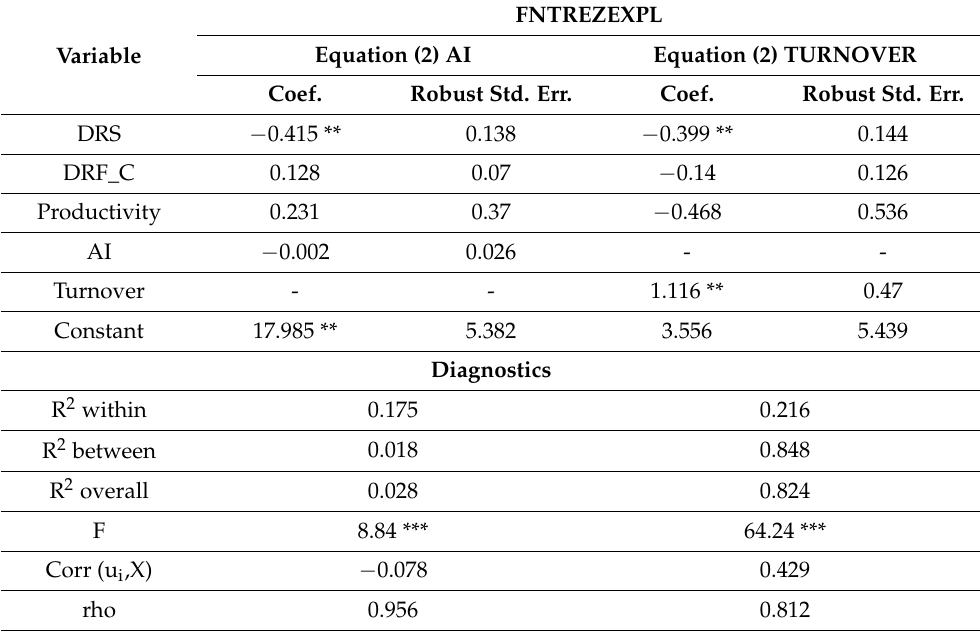
Table 4. Regression results—fixed effects robust models with control factors (Equation